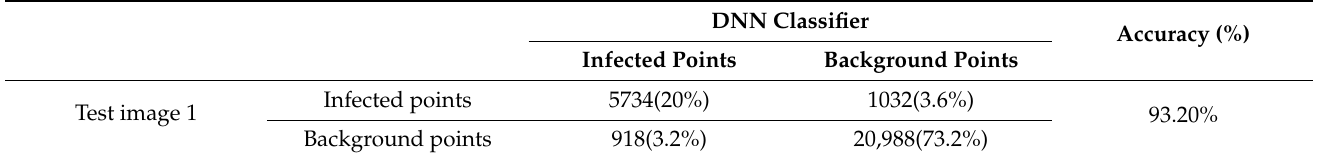
Table 6. Confusion matrix for a test-1 X-ray image sized 32 × 32